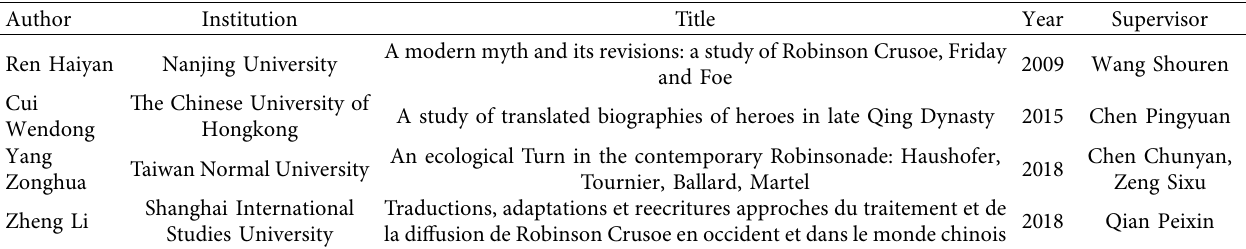
Table 4: Ph.D. Dissertations related to Robinson Crusoe .